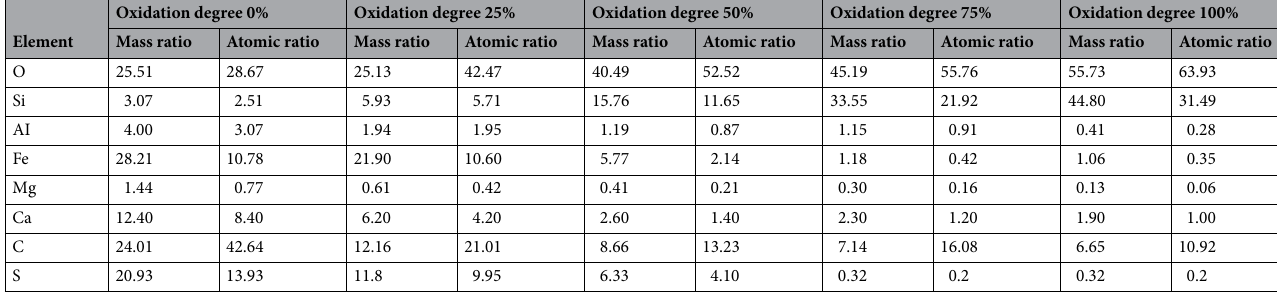
Table 4. Energy spectrum analysis of tailings sand under different acidification and oxidation degree.